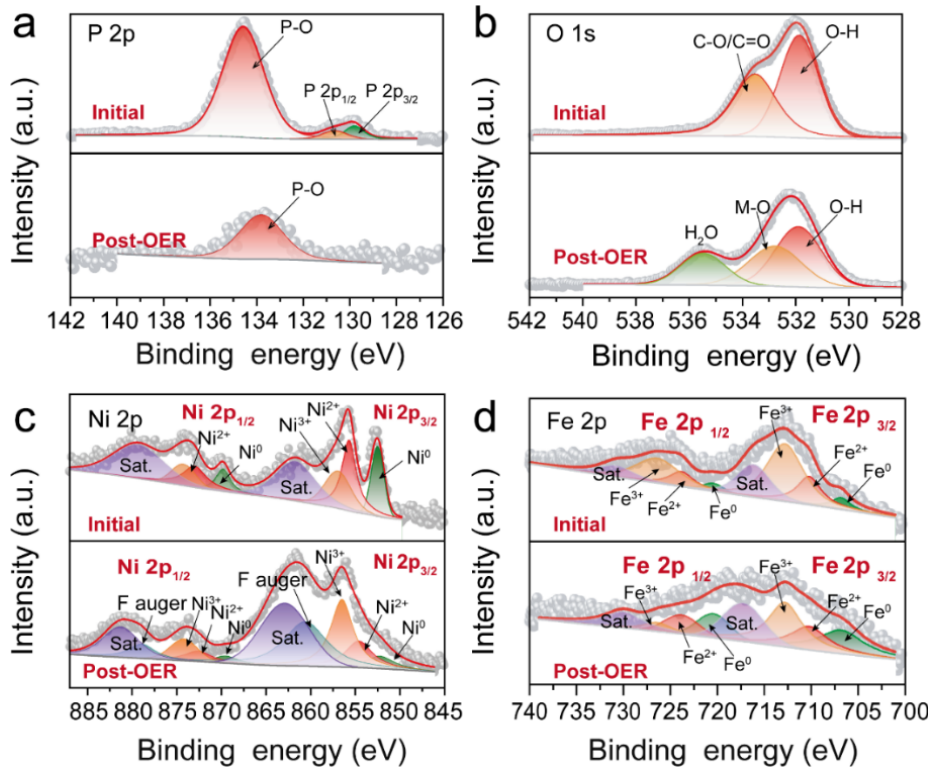
Figure 7. High-resolution XPS spectra of the Ni 5 P 4 /Ni 2 P–FeNi@C sample before and after the OER process. ( a ) P 2p, ( b ) O 1s, ( c ) Ni 2p and ( d ) Fe 2p.